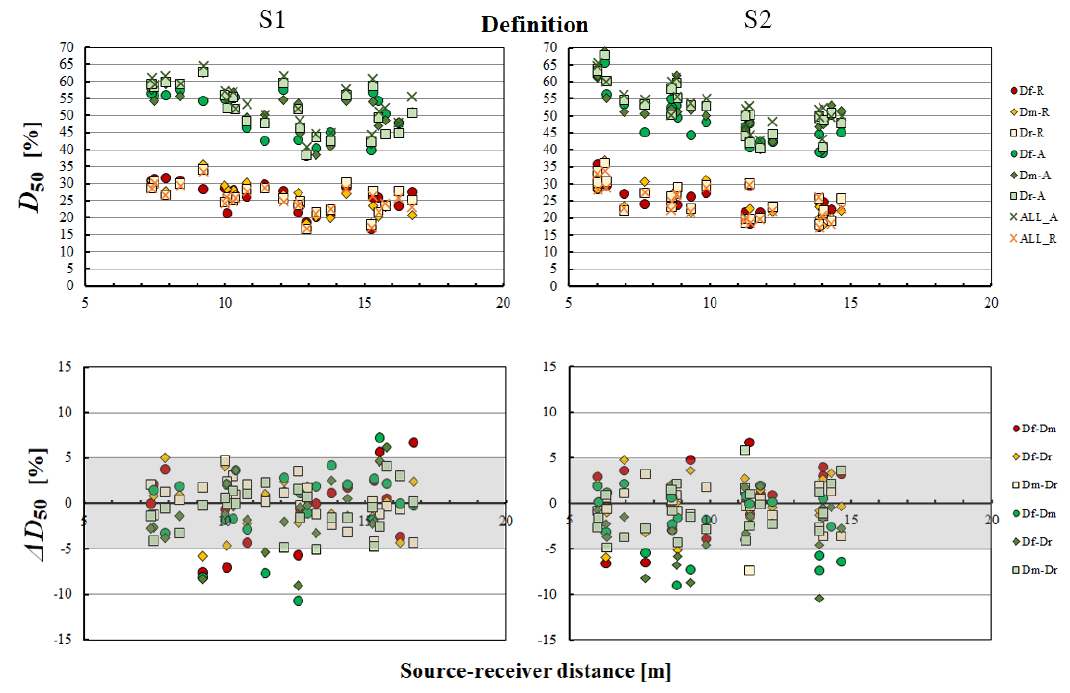
Figure 8. D 50 parameter averaged over 500 Hz and 1000 Hz for S1 and S2 source-to-receiver distance. Δ D 50 represents the parameter differences between the configurations Df-Dm, Df-Dr, Dm-Dr in the reflective (-R) and absorptive (-A) conditions. Di ff erences equal ± 1 JND of the parameters are highlighted through a gray